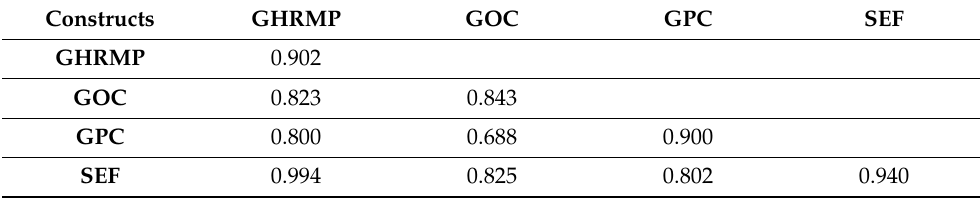
Table 4. Discriminant